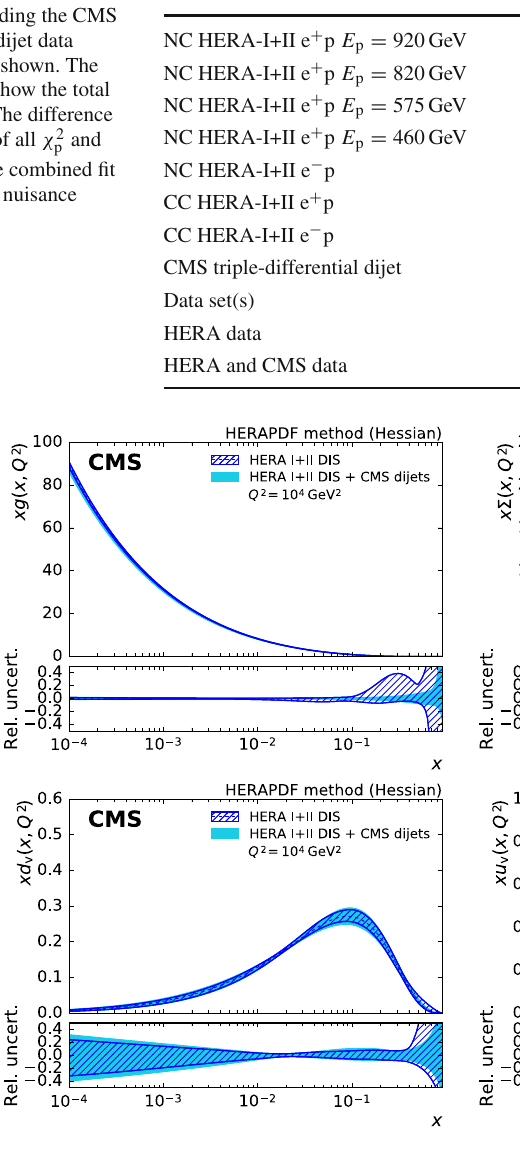
Fig. 9 The gluon (top left), sea quark (top right), d valence quark (bot- tom left), and u valence quark (bottom right) PDFs as a function of x as derived from HERA inclusive DIS data alone (hatched band) and in